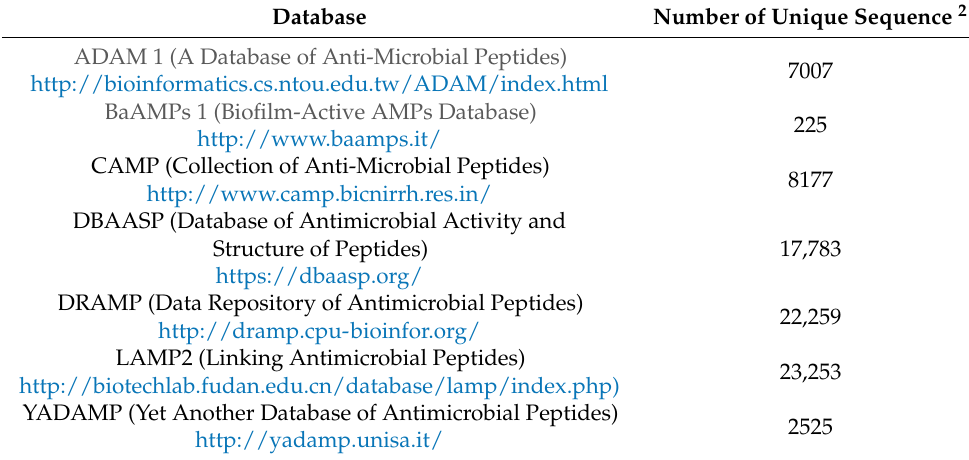
Table 4. List of public AMP database used and their corresponding number of unique